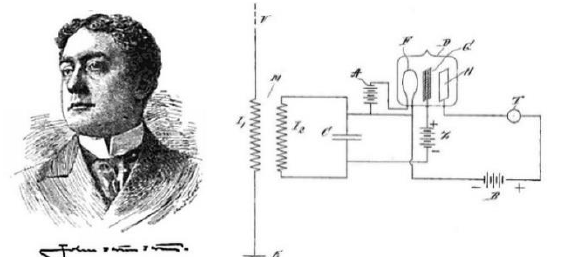
Fig. 2. John S. Stone (1910) and circuit diagram of an audion receiver with bias to the grid from a galvanic cell. J. Stone ’s Patent US884110A